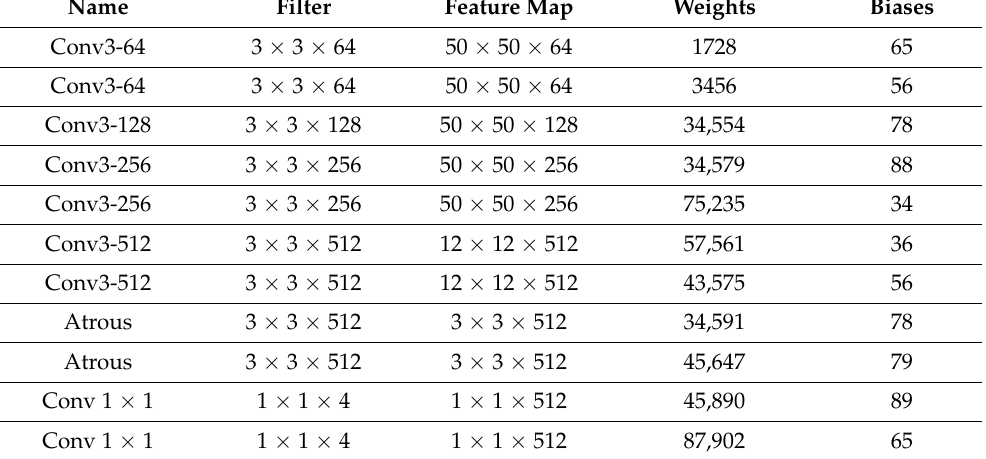
Table 1. VGG16_CNN’s weight and